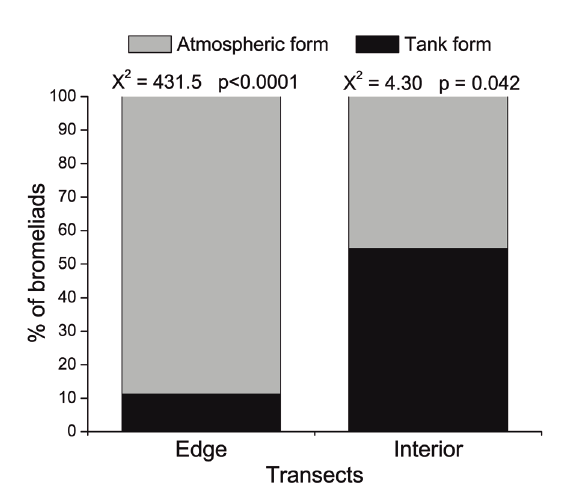
Figure 4 - Abundance of bromeliads (mean and standard error in 25m²) in each host tree species recorded in Itapanhaú mangrove.